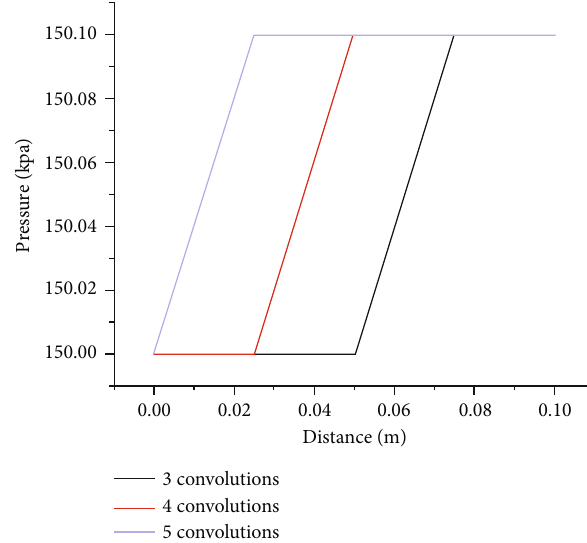
Figure 5: Pressure at di ff erent positions of coil with varying number of